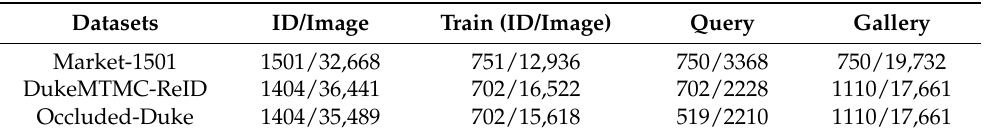
Table 1. Dataset information. ID denotes the total number of identities in the dataset. The images denote the total number of images in the